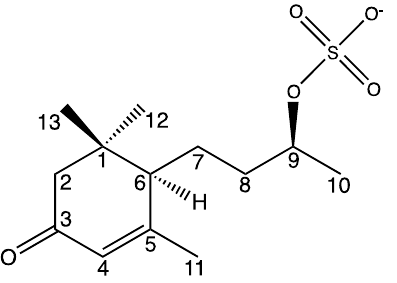
Figure 4. Structure of blumenol C sulfate ( 1 ). Numbering of carbon atoms is in accordance to